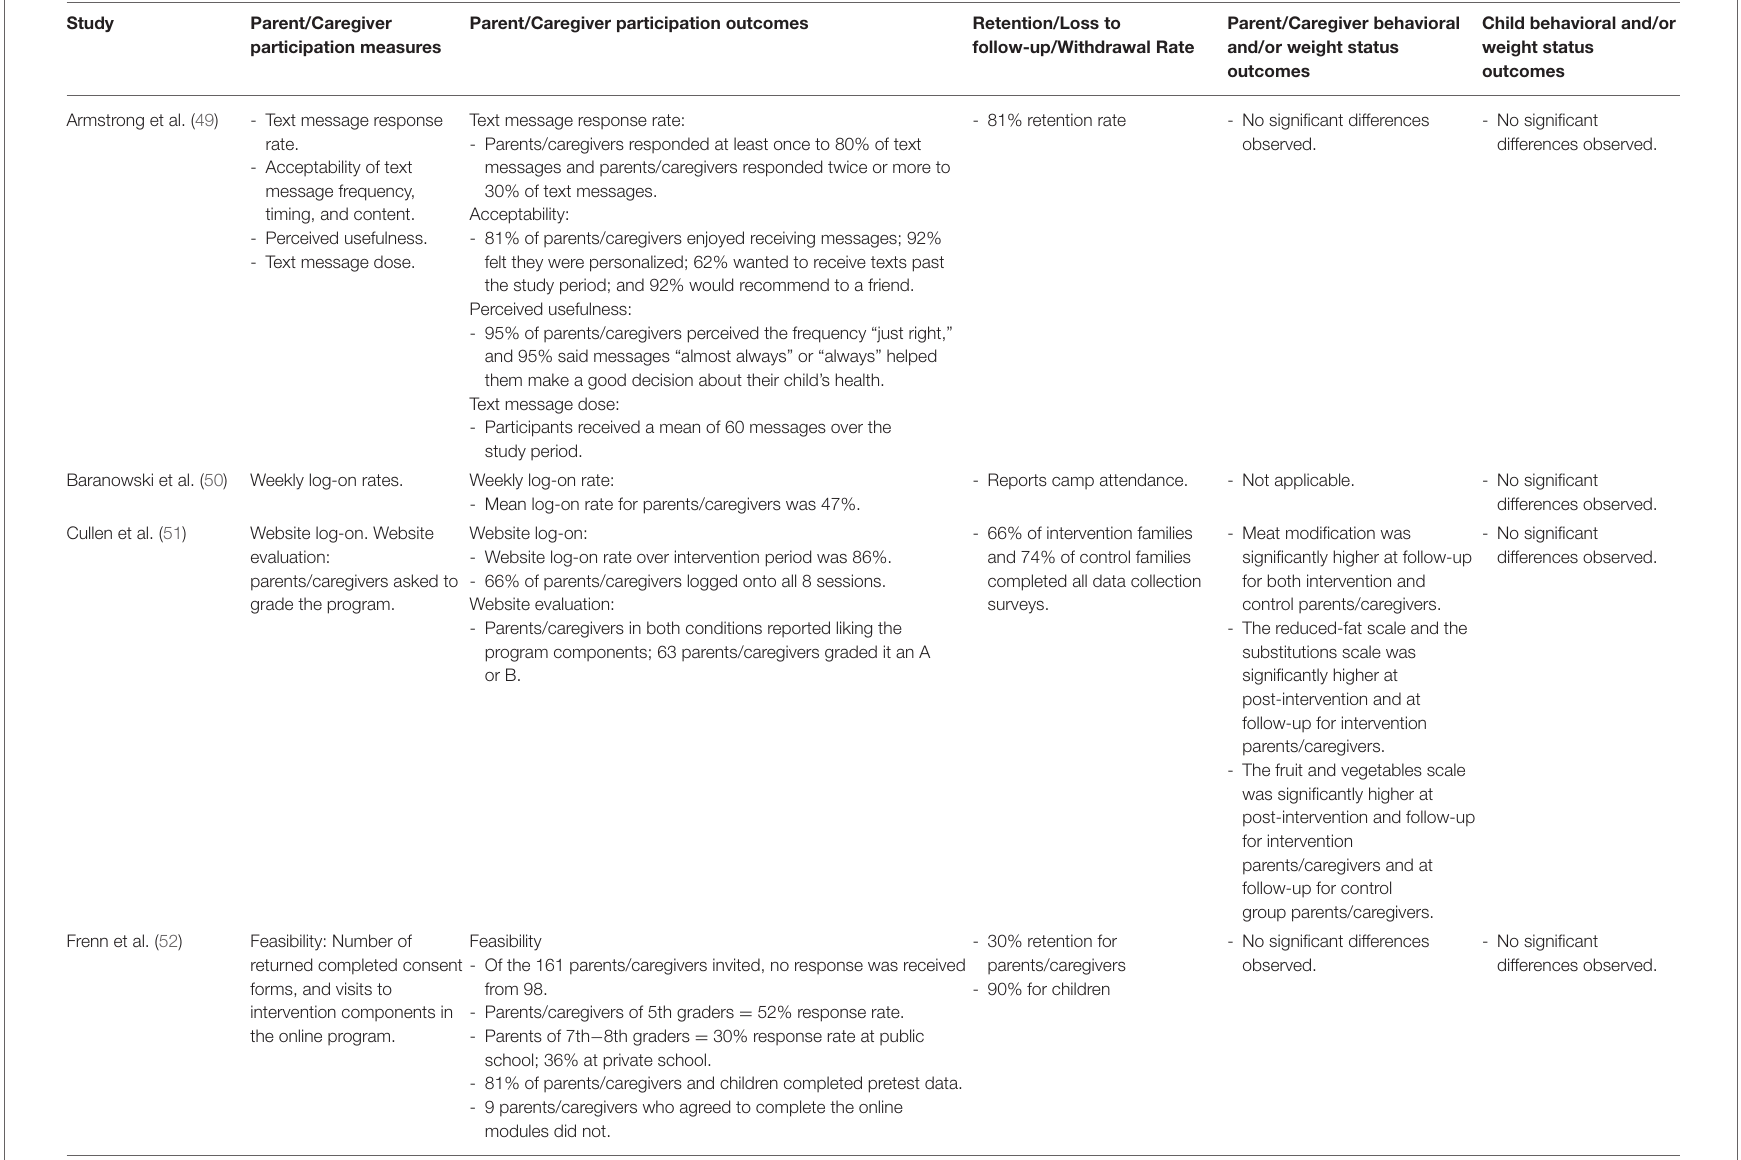
TABLE 2 | Parent/caregiver participation in digital health interventions and behavioral and weight status